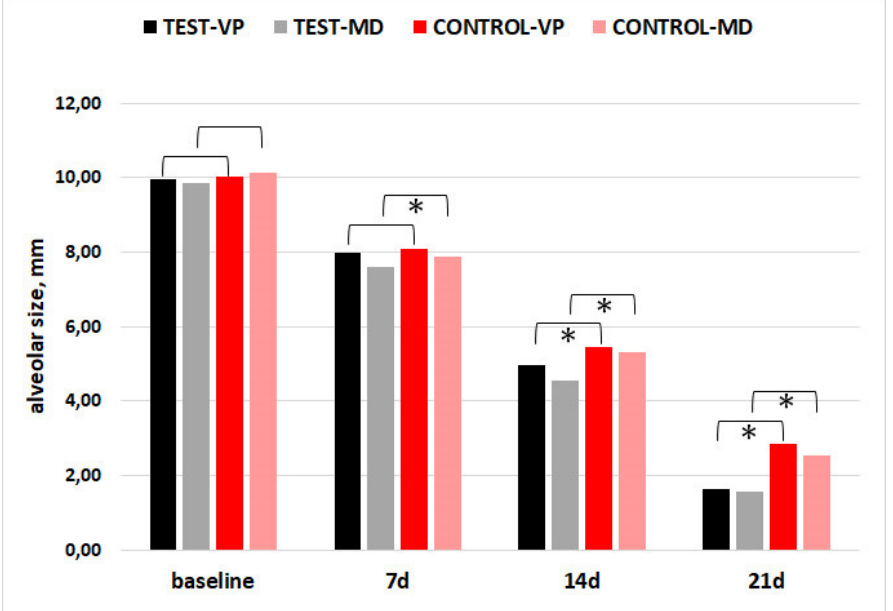
Figure 3. Alveolar socket size in the vestibulo-palatal/lingual (VP) and mesio-distal (MD) dimensions. Asterisks indicate significant differences between CGF and CTR groups ( p < 0.05). The socket closure % (vestibulo-palatal/lingual, VP; mesio-distal, MD) was greater in the CGF group relative to the control in both dimensions, and the difference was significant at 14 and 21 days ( p < 0.001), as shown in Figure 4.